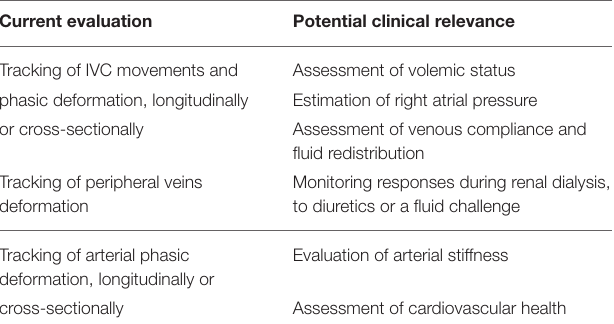
TABLE 1 | Current evaluation and potential clinical relevance of image-processing algorithms applied to vascular